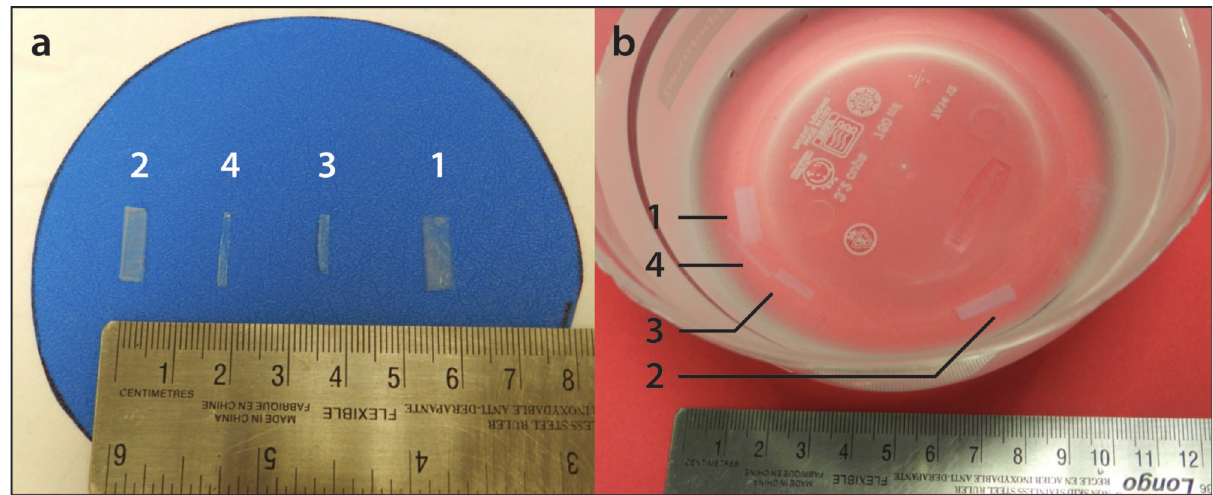
Figure 1 - Layout of cartilage-mimicking phantoms (1-4) on a planar surface in ambient air (a) and embedded in a saline-Magnevist s bath (b).